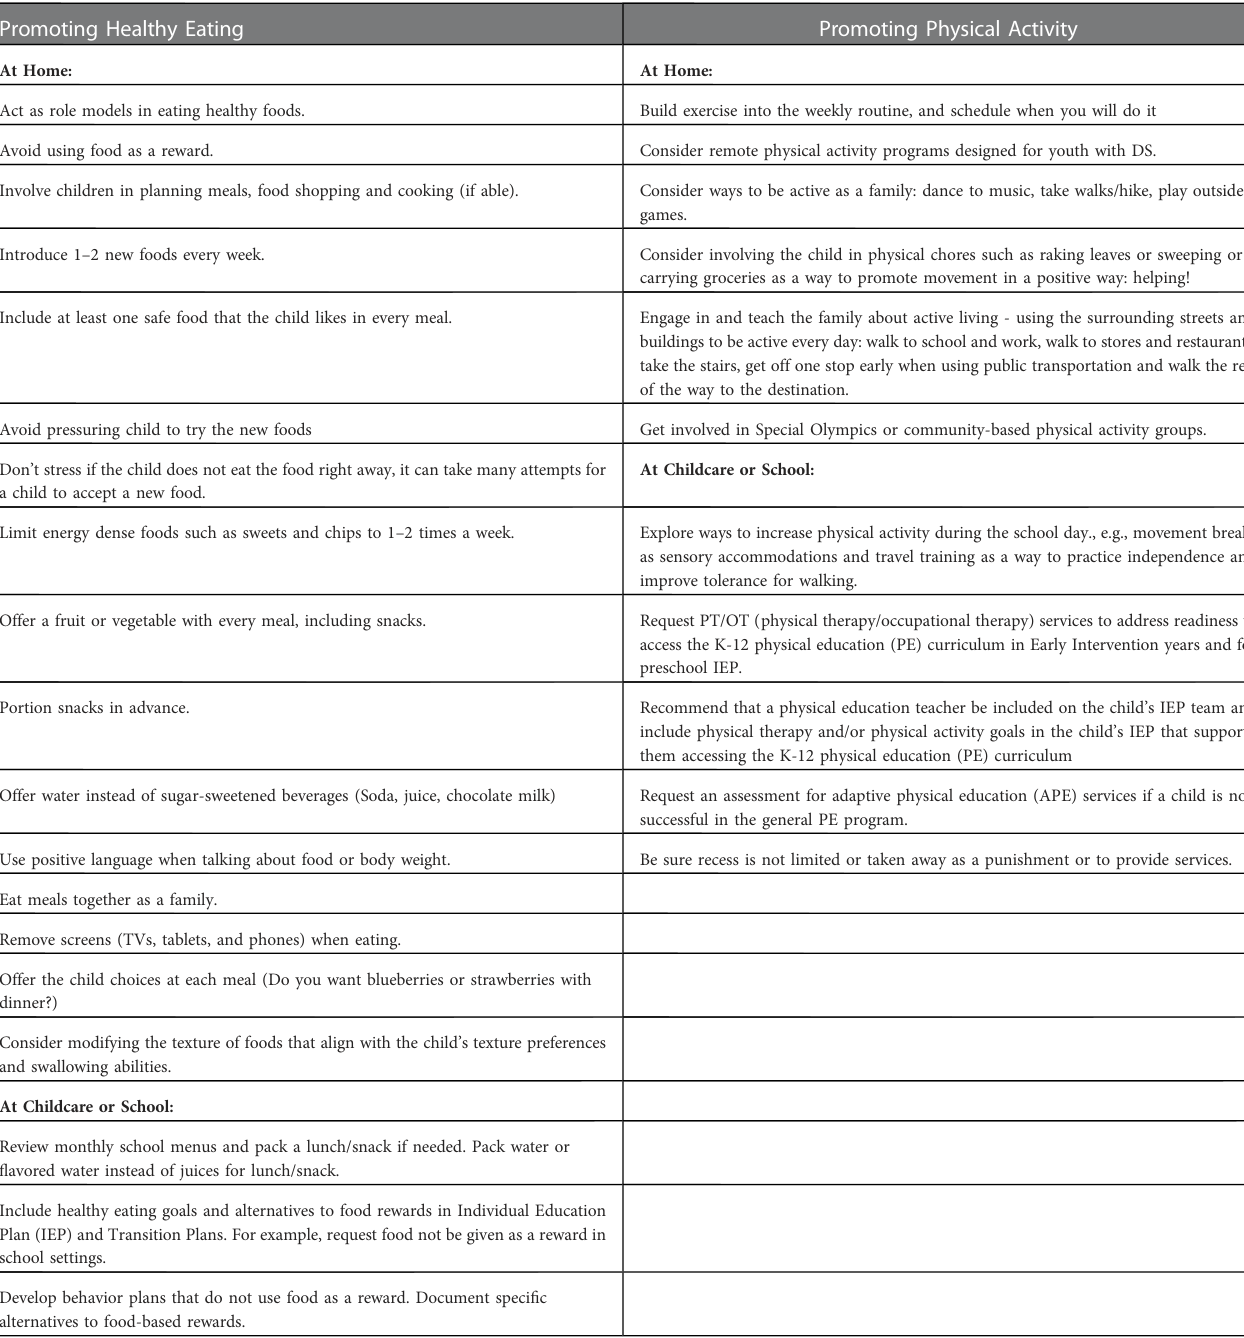
TABLE 5 Strategies for families to support their children with down syndrome to adopt health-promoting behaviors. Promoting Healthy Eating Promoting Physical